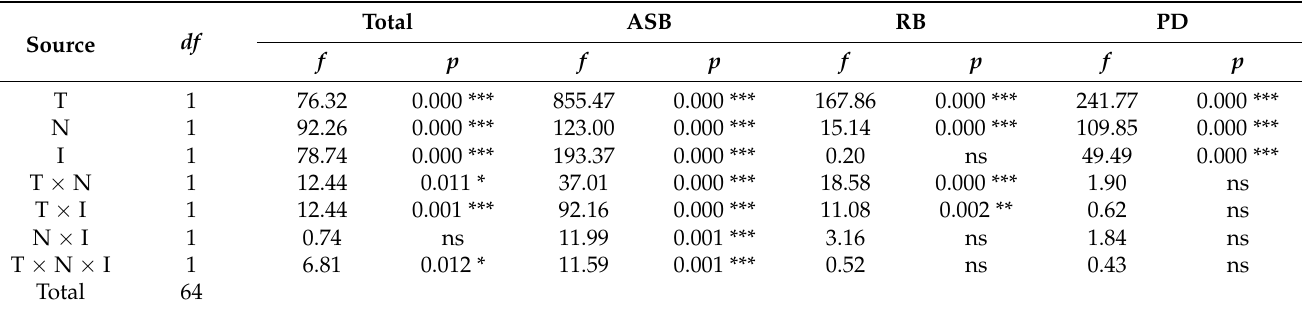
Table 1. Combined ANOVA evaluating effects of treatment timing (T), nitrogen (N), irrigation (I) and their interactions on bud number and shoot population density. The data were collected in 2018 and